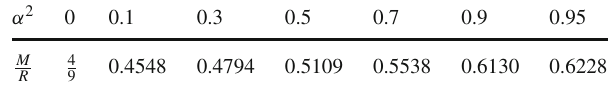
for different values of α 2 R